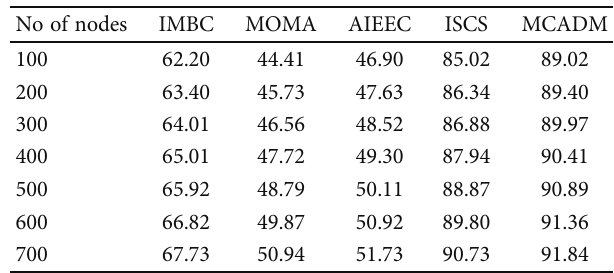
Table 2: Management of reduced function device